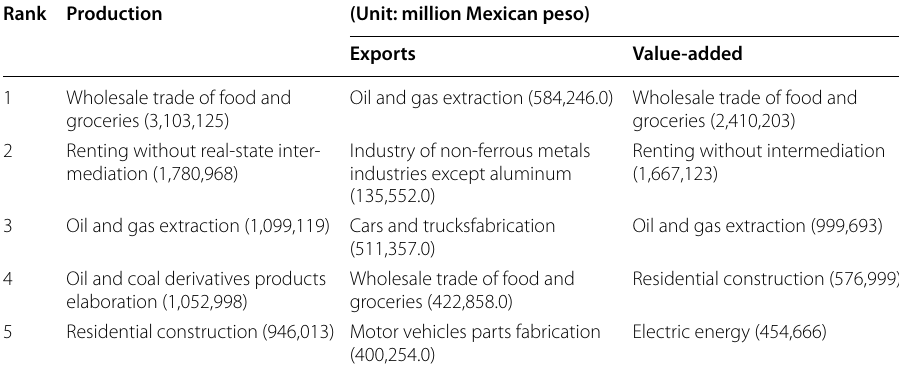
Table 3 Top ranked sectors according to macroeconomic variables (2012). Source: Results from authors calculations